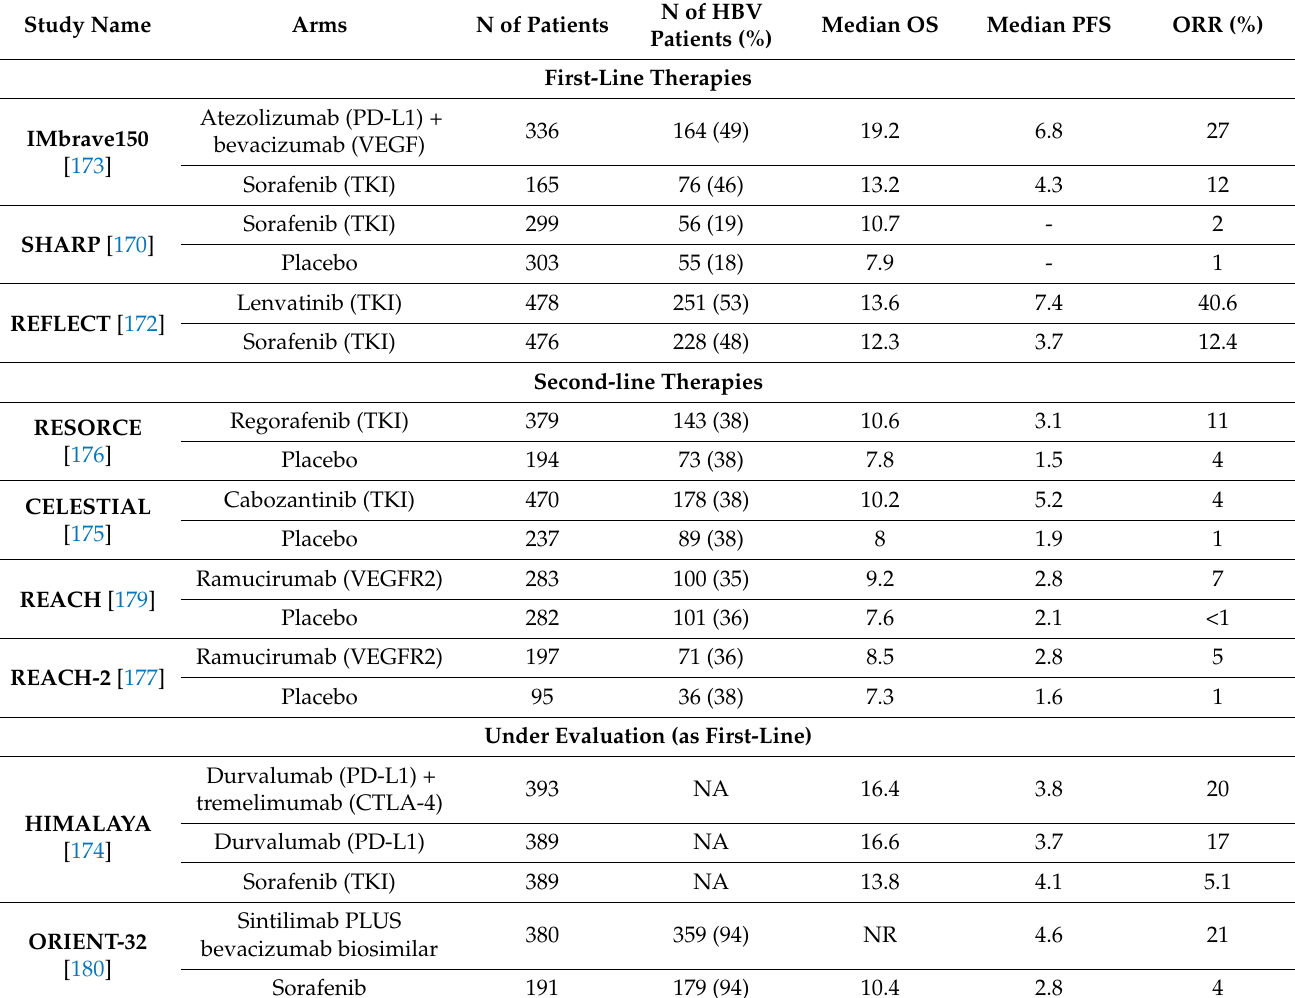
Table 3. RCT of registrative systemic therapies for HCC exploring the HBV patients considered in the arm of